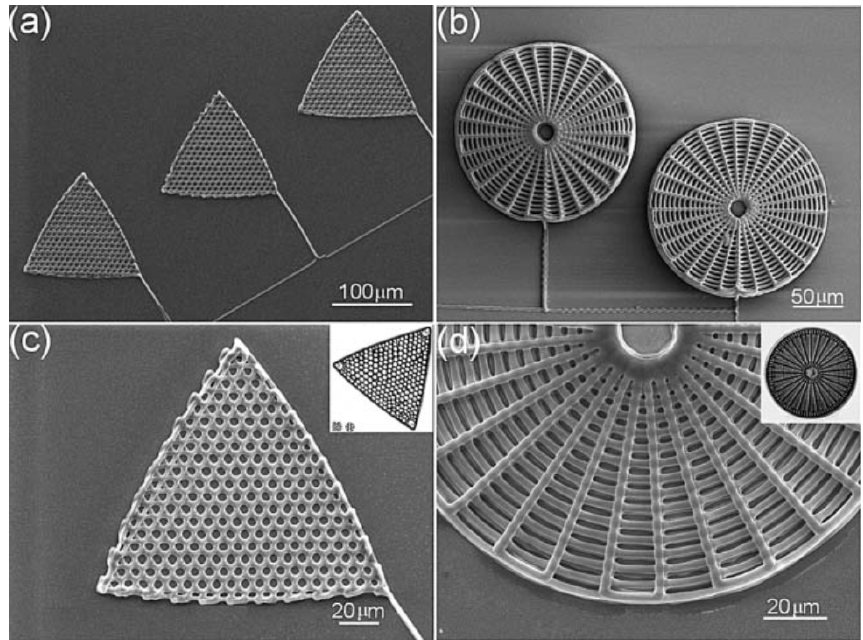
Figure 10. SEM images of polyamine-rich scaffolds assembled by direct ink writing and reproducing the morphology of a T. favus ( a ) and a A. ehrenbergii (b) diatom valve. Magnification views are reported in ( c , d ). Reproduced with permission from Ref.